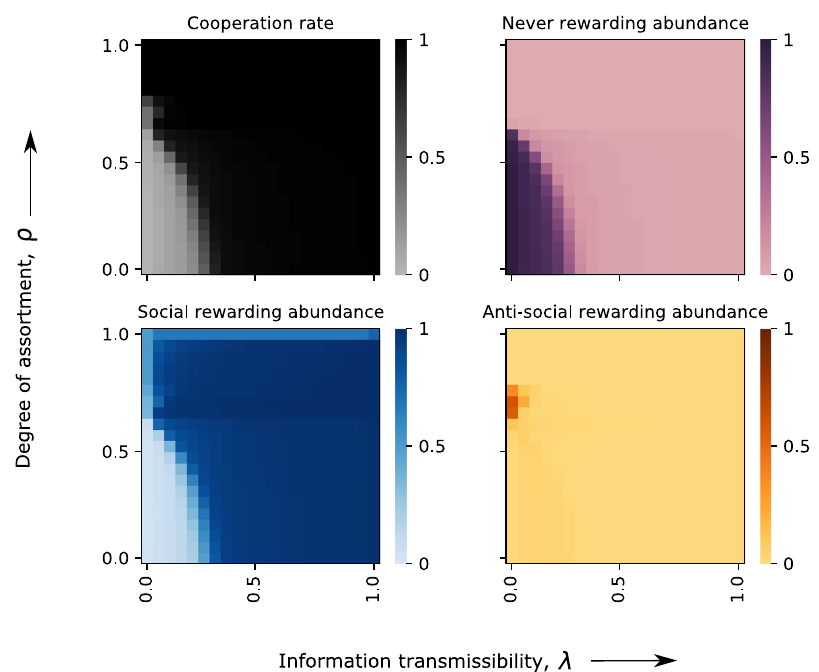
Fig.3|Co-evolutionofcooperationandrewardinginassortedpopulations. We explore to which extent population structure affects the strategies that evolve in pairwise interactions. To this end, we systematically vary the population's infor- mation transmissibility λ and the assortment parameter ρ . The limiting case of no assortment ( ρ =0) corresponds to the previously considered case of well-mixed populations.Intheotherlimitingcaseoffullassortment( ρ → 1),individualstendto